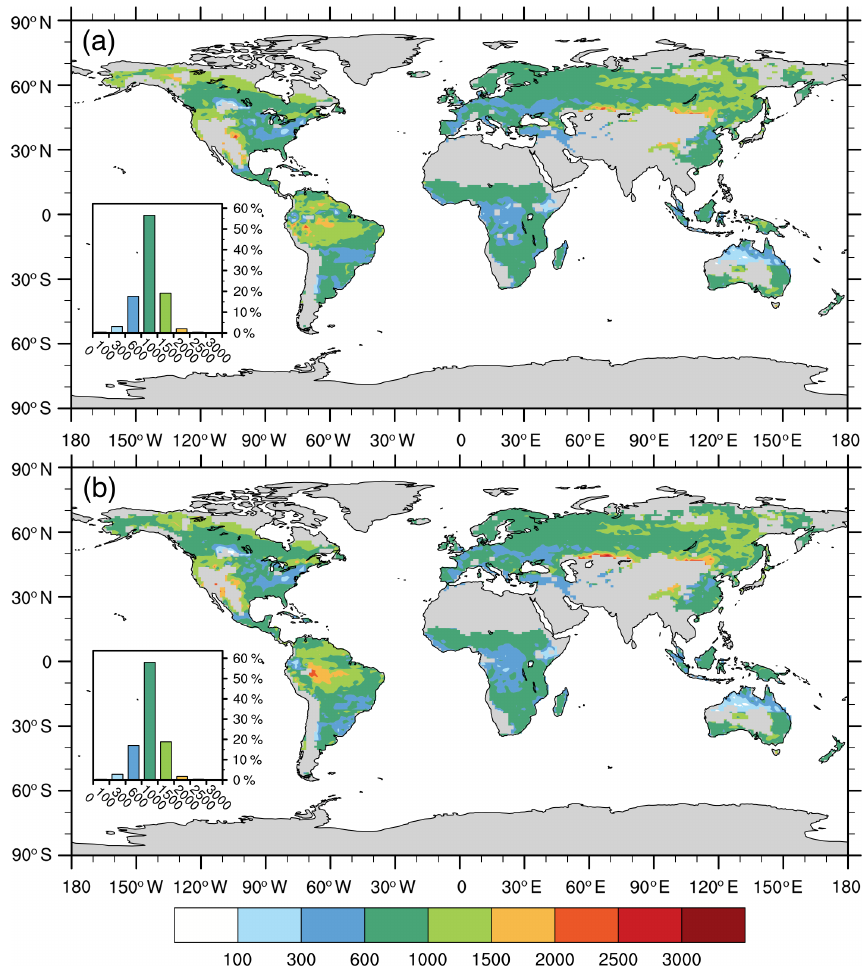
Figure 5. Comparison of CESM-RESFire-simulated annual median injection heights (m) of fire plumes in the (a) present-day (CTRL1) and (b) RCP4.5 (CTRL2) scenarios. The inlets show the statistical distributions of all plume injection heights in the model grid cells of each